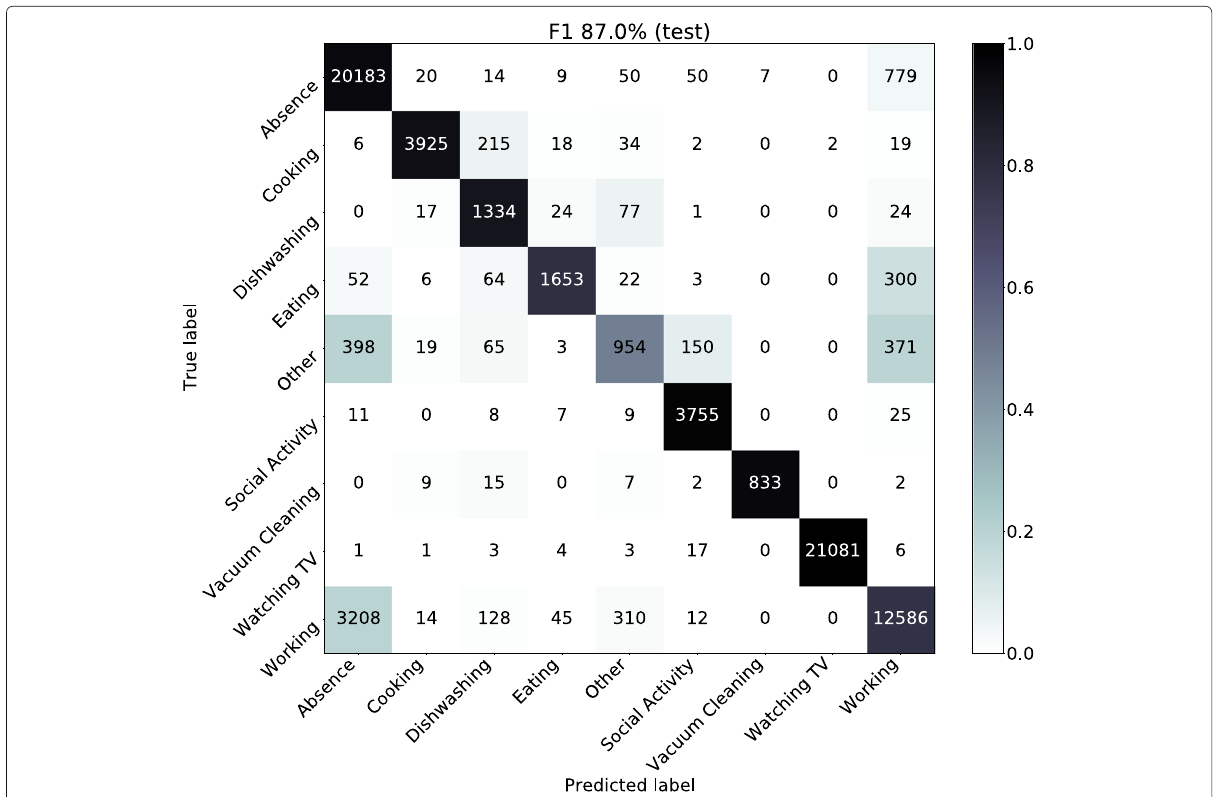
Fig. 2 The confusion matrix (CM) of the best prediction on the test set of the DCASE 2018, task 5